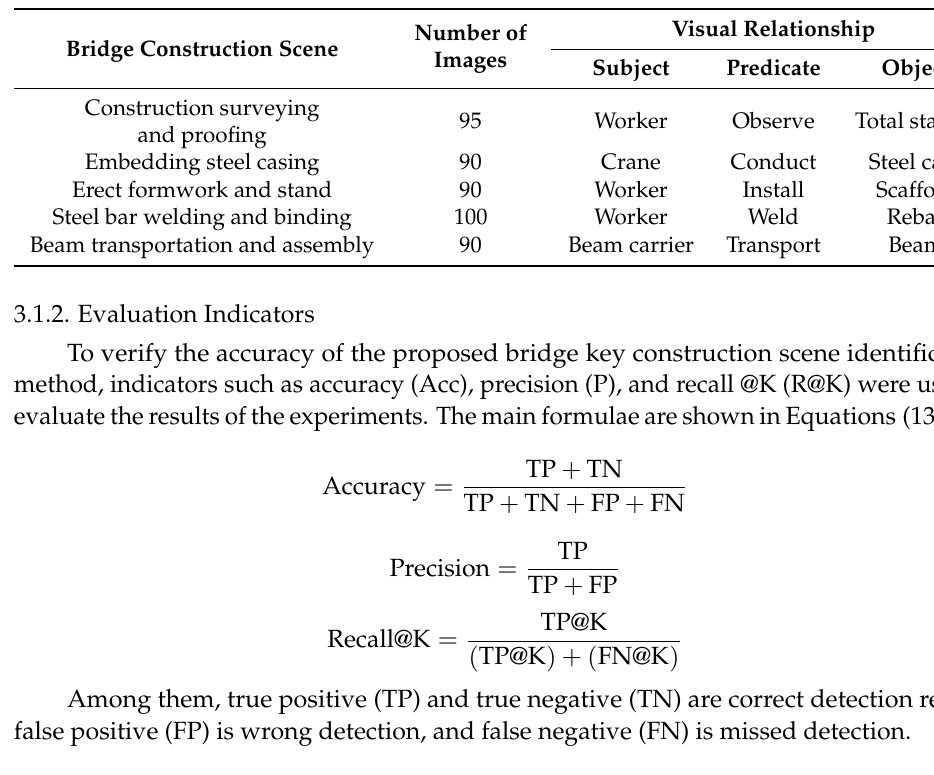
Table 3. Number and interrelationship of images in each construction